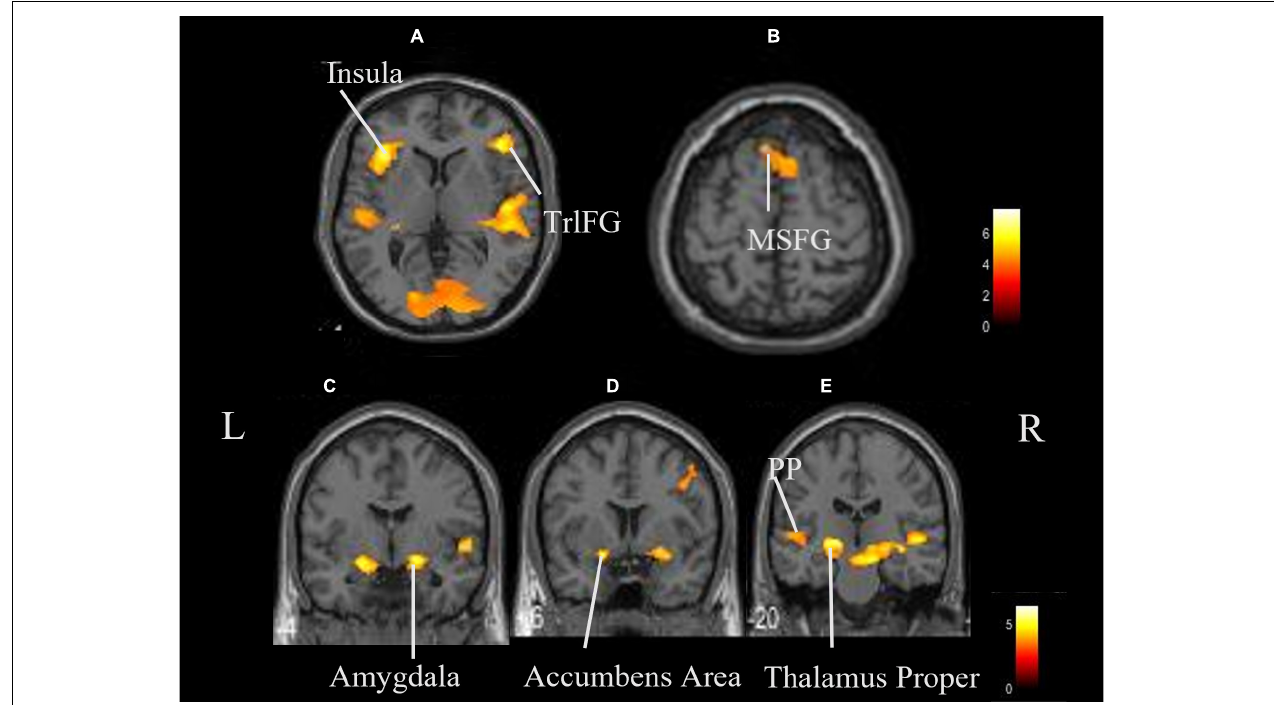
FIGURE 3 | Whole brain activation while listening to ASMR compared with the resting state. Significant activation was observed in the right triangular part of the left thalamus proper, left insula, right triangular part of the inferior frontal gyrus, right cerebellum exterior, left accumbens, right amygdala, left medial superior frontal gyrus, and left planum polare. (A,B) Axial view. (C–E) Coronal view. L, left; R, right. TrlFG, triangular part of the inferior frontal gyrus; MSFG, medial superior frontal gyrus; PP, planum polare.